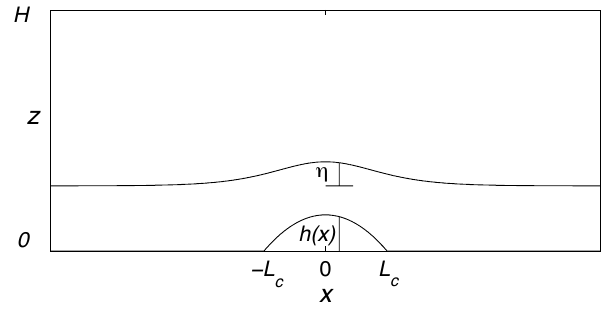
Fig. 1. Sketch showing the core boundary h(x) and the streamline displacement η . The stagnation points are at x =± L c